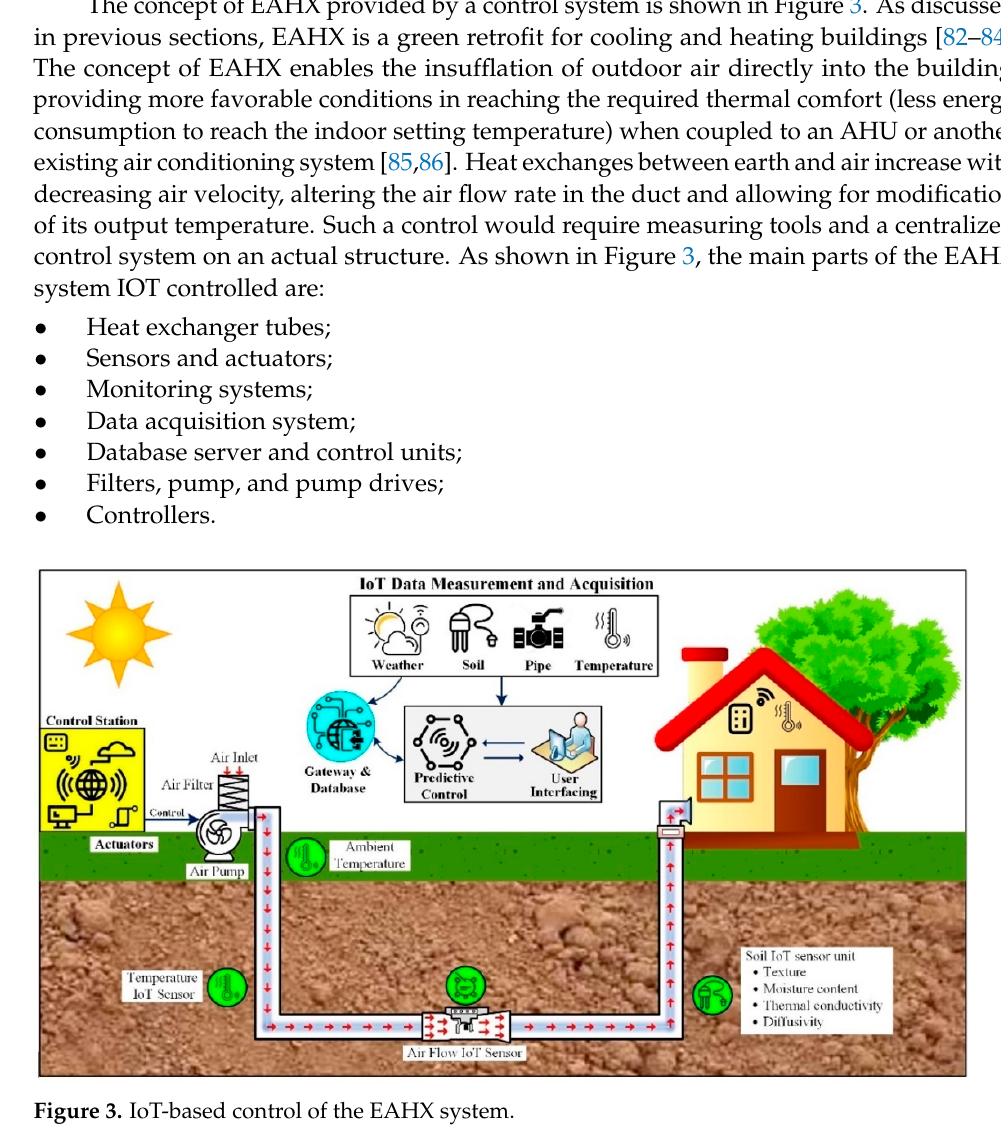
Figure 3. IoT-based control of the EAHX system.